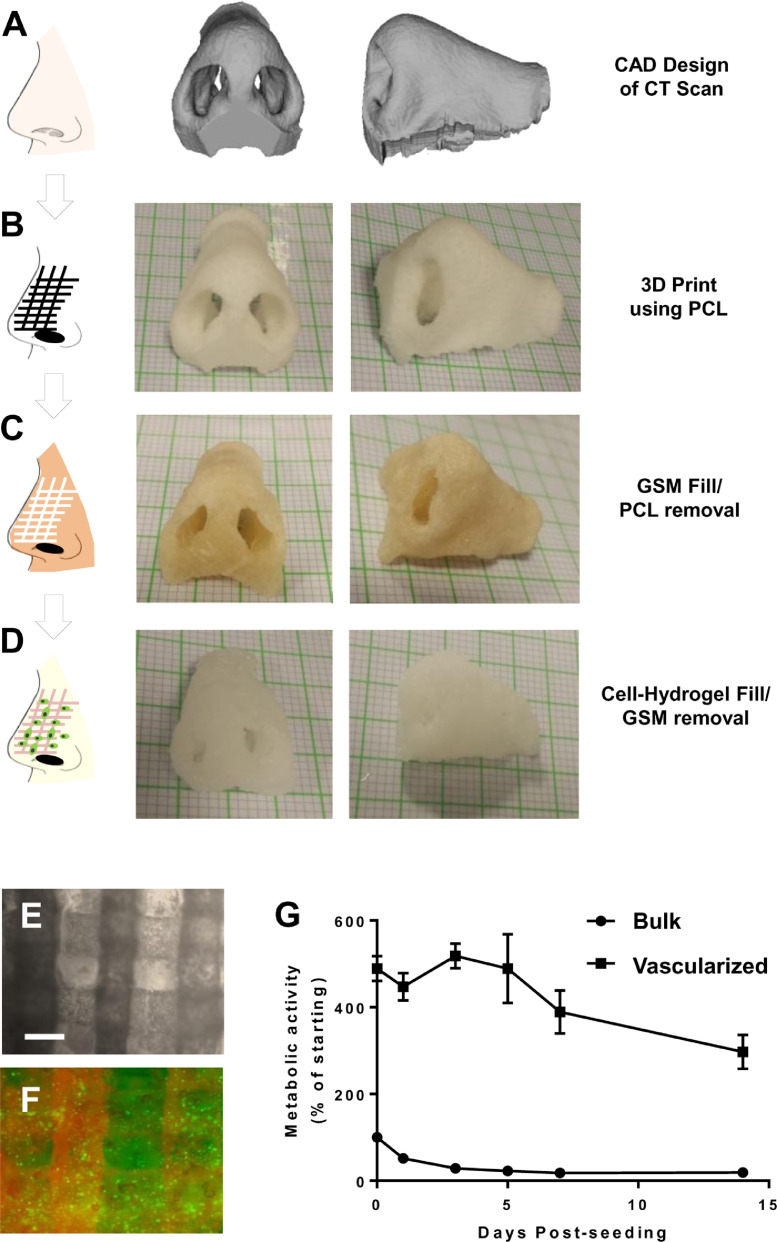
GSM-mediated vascularization of a human-scale nose constructs. (A) Computer-aided design projection created from a CT scan of a human nose. (B) 3D printed porous nose using PCL as an initial scaffold structure. Graph paper is 1mm2/square. (C) GSM filled nose with PCL removed using chloroform solubilization. (D) Alginate filled nose with GSM removed by incubation in phenol-red free growth media at 37°C for 3 h (120rpm mixing). GSM and Alginate were injected into the PCL and GSM structures, respectively using an air driven syringe. (E,F) Microscopy of a section of the nose Alginate constructs (containing 1 × 107/ml iHMSC-GFP cells) showing (E) light microscopy of the vessels created by the sacrificial GSM, and (F) vessels shown by injection of TMR (fluorescent red) label and interstitial Alginate hydrogel containing iHMSC-GFP cells (fluorescent green) signal. Bar is 500 µm. (G) Equivalent non-vascularized and GSM-vascularized nose constructs were examined without manipulation using PrestoBlue metabolic assay over a 14-day time course. Metabolic activity was ratioed to avascular nose construct metabolism at time point 0 (denoted as 100%). Initial metabolic activity is higher in the vascular constructs as they promote diffusion of the assay reagent and produce a more efficient reaction condition. Vascularized noses increase metabolism with a decrease slightly below starting levels over the 7 day period. Avascular constructs did not increase metabolism over the experiment (n=3).